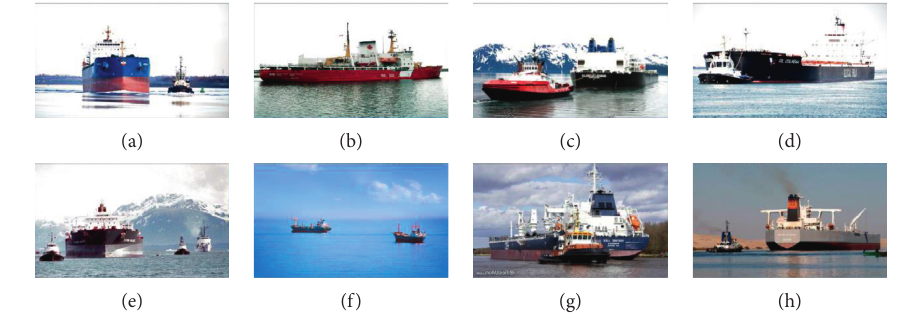
Figure 9: Dataset by ourselves. Table 1: Experimental results of different optimization strategies.